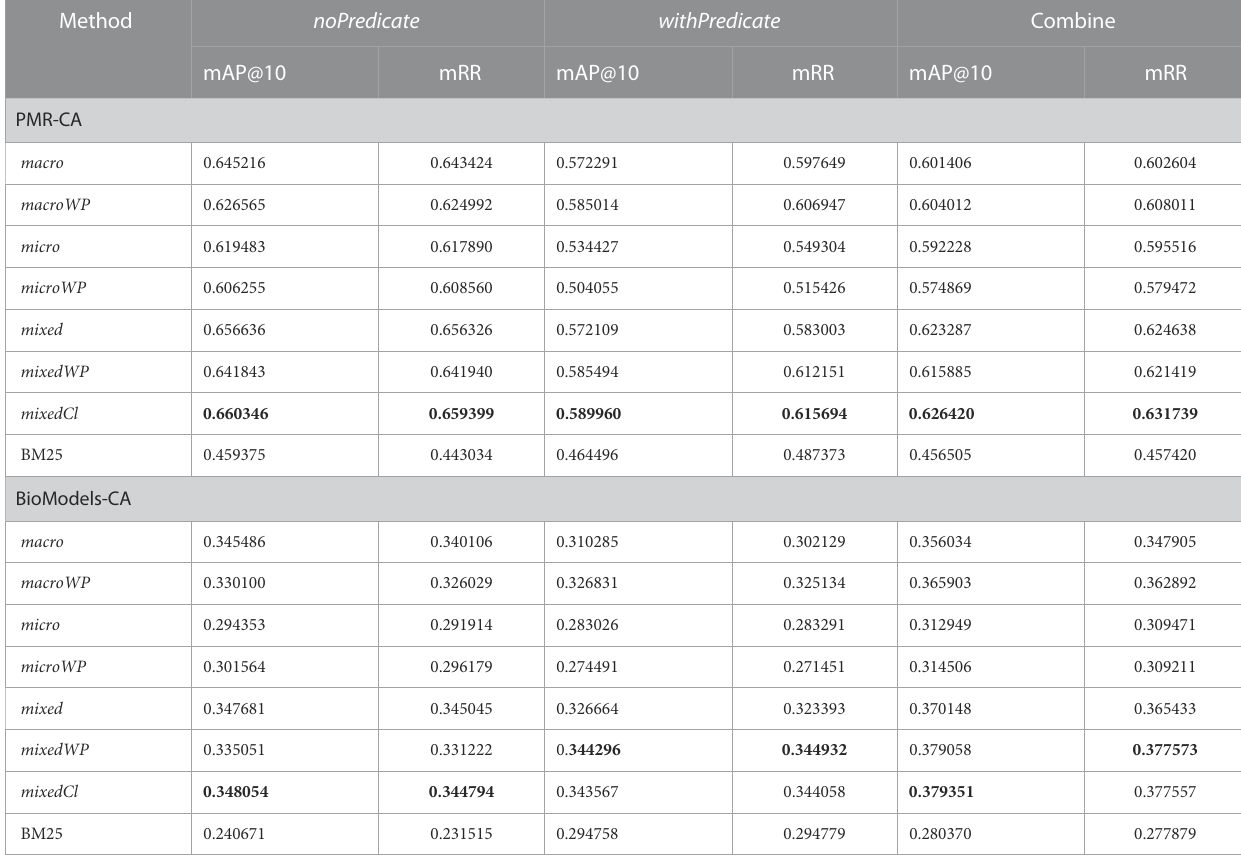
TABLE 3 CASBERT performance over three query-entity pair sets and seven searching methods compared to the bag-of-words method (BM25) measured using mAP@ 10 and mRR . The numbers of entities in the PMR and the BioModels are 4,652 and 54,456 respectively.